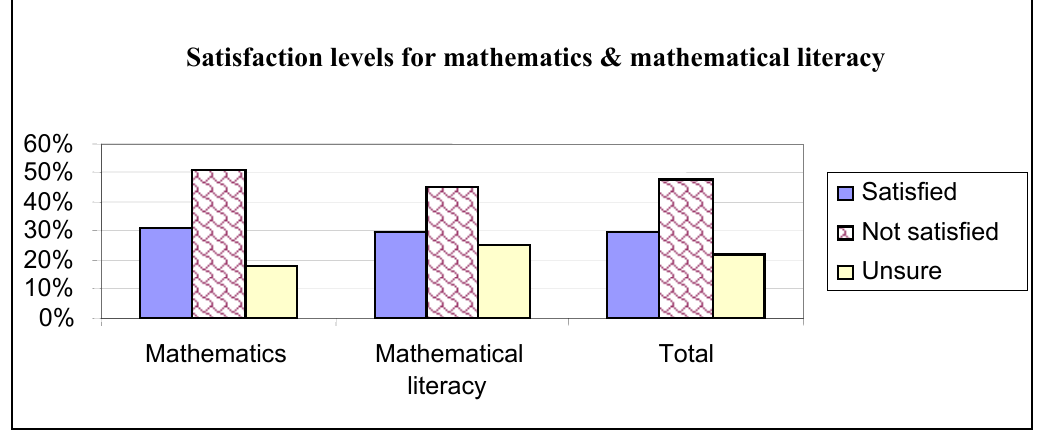
Figure 1 : Satisfaction levels